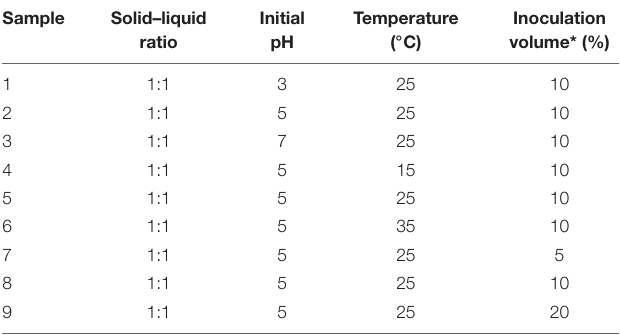
TABLE 1 | Parameter setting in microbial stabilization experiments. Sample Solid–liquid